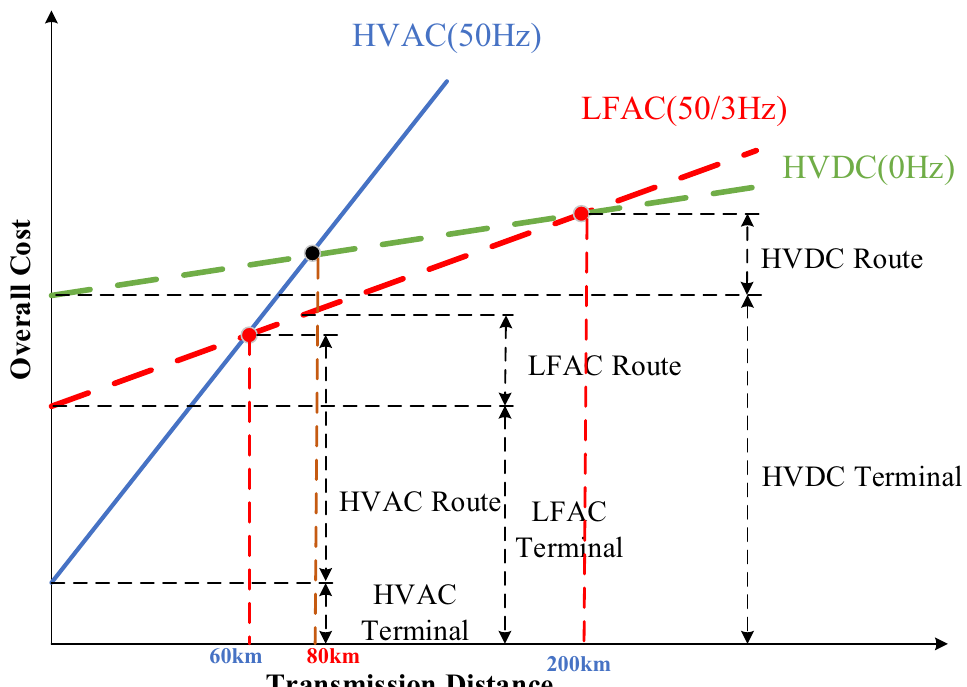
Fig. 19 Relationship between cost and distance for the three technologies